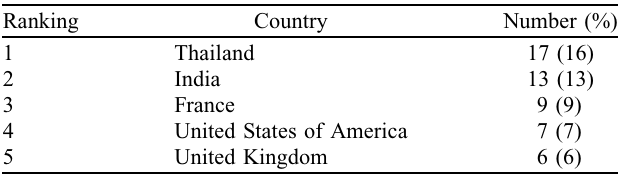
Table 3. Showing the top five countries with abstracts proceeding to full publication. Total N =